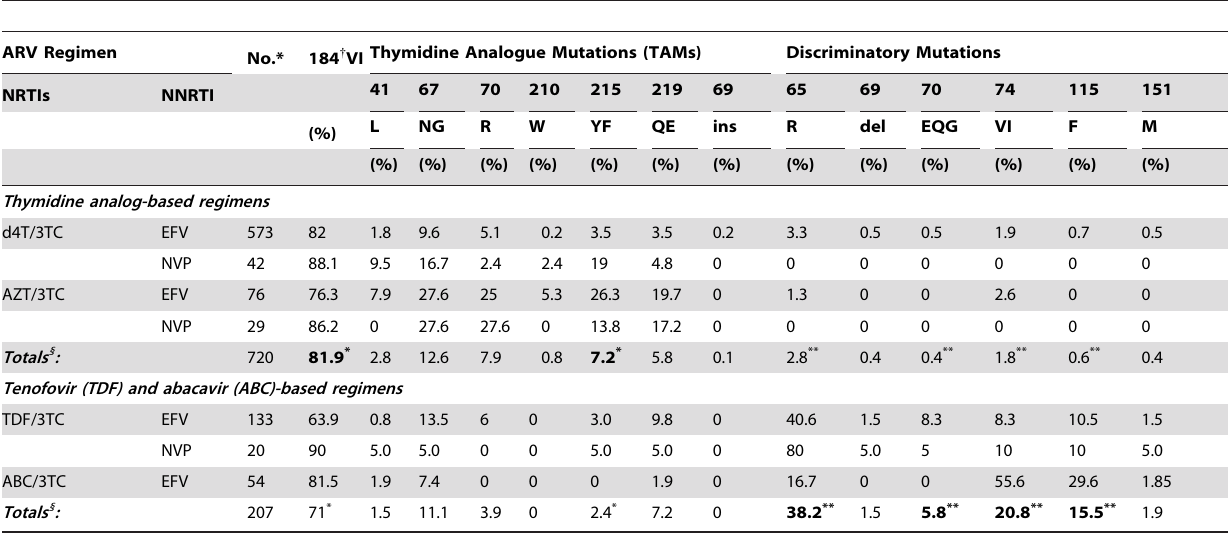
Table 3. Nucleoside RT Inhibitor (NRTI) Resistance Mutations: Percent Occurrence in Patients Treated with Dual NRTI plus Nonnucleoside RT Inhibitor (NNRTI) First-Line Antiretroviral (ARV) Regimens.